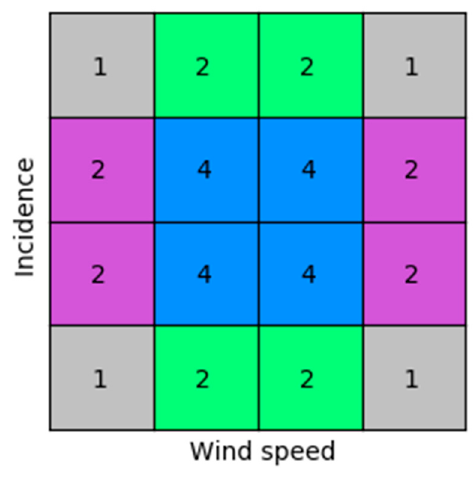
Figure 2. Weighting strategy of observables to form empirical geophysical model function.